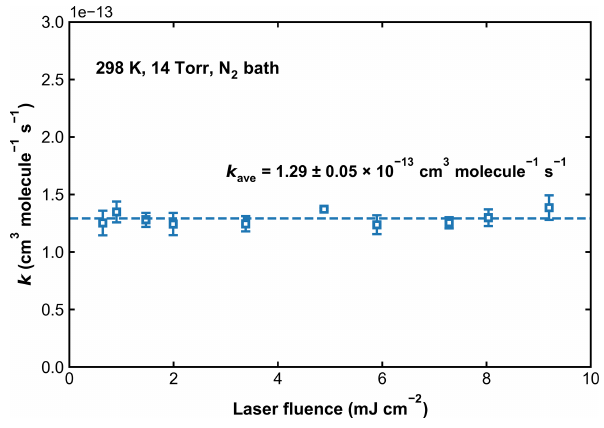
Figure 6. Values of k 1 measured at 298K and in 14Torr of N 2 bath gas. The 248nm laser fluence was varied by a factor of ∼ 14. The dashed line represents the average rate